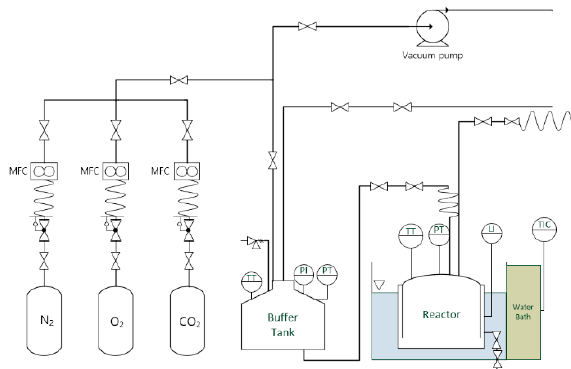
Figure 1. Schematic diagram of experimental apparatus.